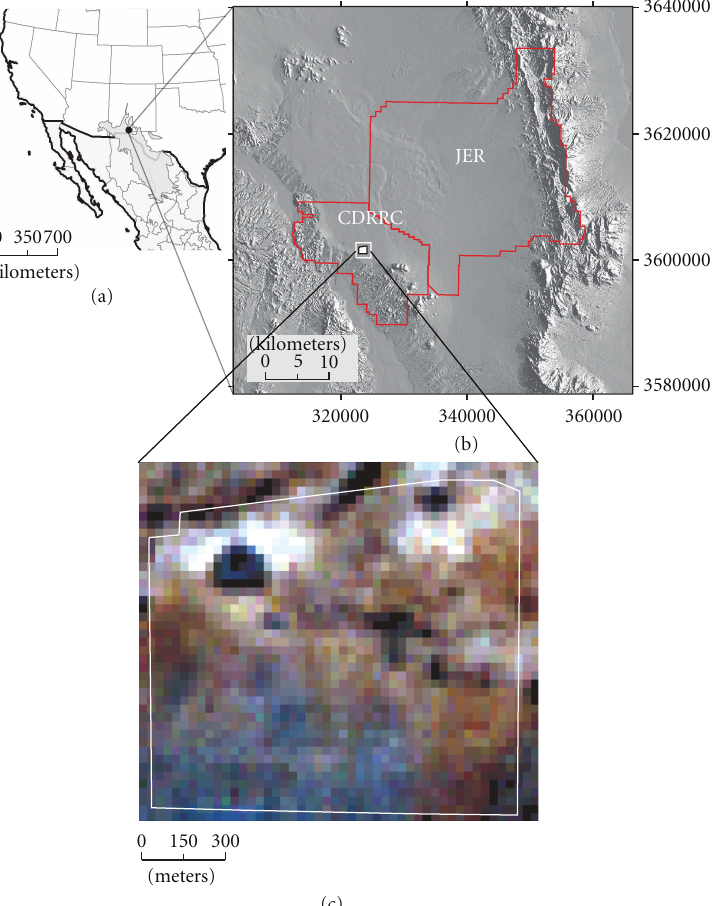
Figure 1: Location of the Jornada Basin LTER (JRN) in southern New Mexico at the northern extent of the Chihuahuan Desert (depicted in gray in Panel (a)). The 150ha study site (white on inset map in Panel (b)) occurs on the Chihuahuan Desert Rangeland Research Center (CDRRC), which together with the Jornada Experimental Range (JER) constitutes the JRN. Topographic complexity of the JRN is illustrated with a shaded relief map from a 10m digital elevation model. Panel c is a natural color composite Landsat 7 ETM+ image of the study site (in white outline). Color bands display as Landsat 7 band 3 (red), band 2 (green), and band 1 (blue) with no histogram stretch